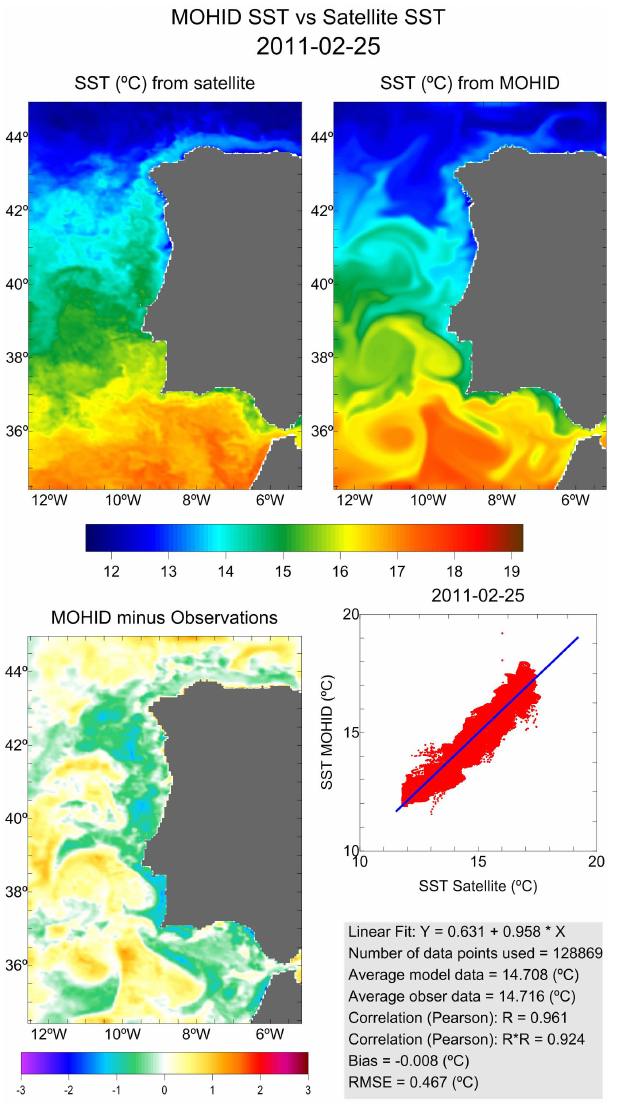
Fig. 9. Sea surface temperature (SST) maps on 7 July 2011 retrieved from remote sensing data (upper left panel), simulated by the model (upper right panel), and their difference (lower pannel). Linear fit between model and data, and results from basic statistical analysis are also